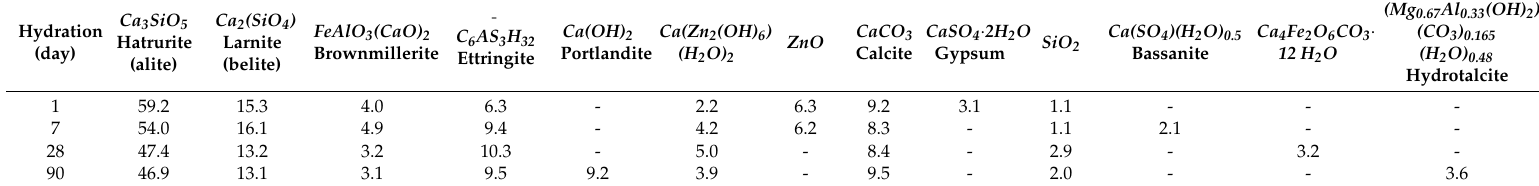
Table 6. Mineral composition of sample with